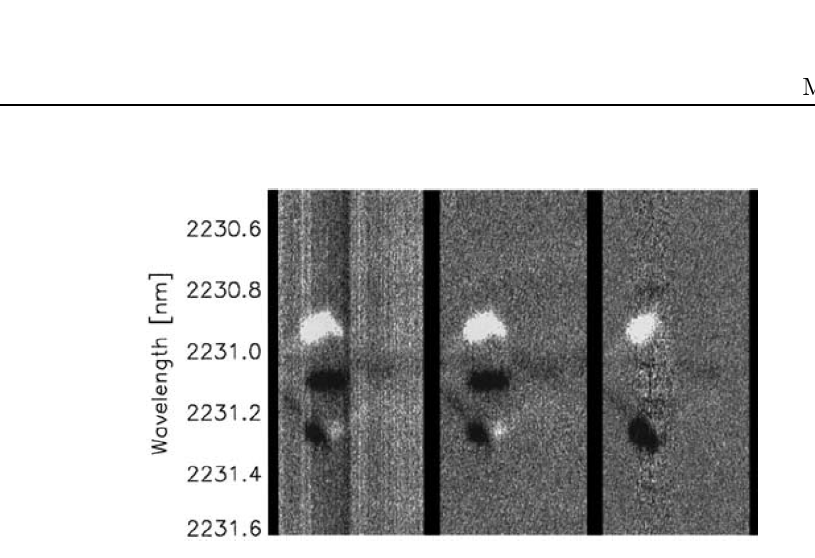
Figure 25: Stokes V spectral profiles of a Ti i line at 2231 nm. The two Zeeman split components are completely resolved in the sunspot umbra, and the line does not form in the high temperatures of the solar photosphere. With a magnetic sensitivity larger than the Fe i 1565 nm spectral line, this line is uniquely suited for probing the magnetic fields in sunspot umbrae. Image reproduced with permission from Penn et al. (2003b), copyright by